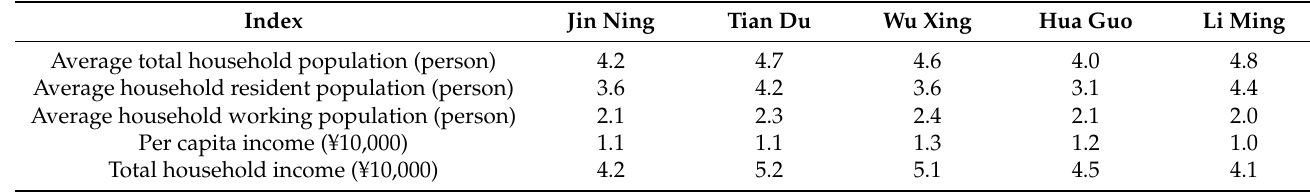
Table 2. Demographic information of sample